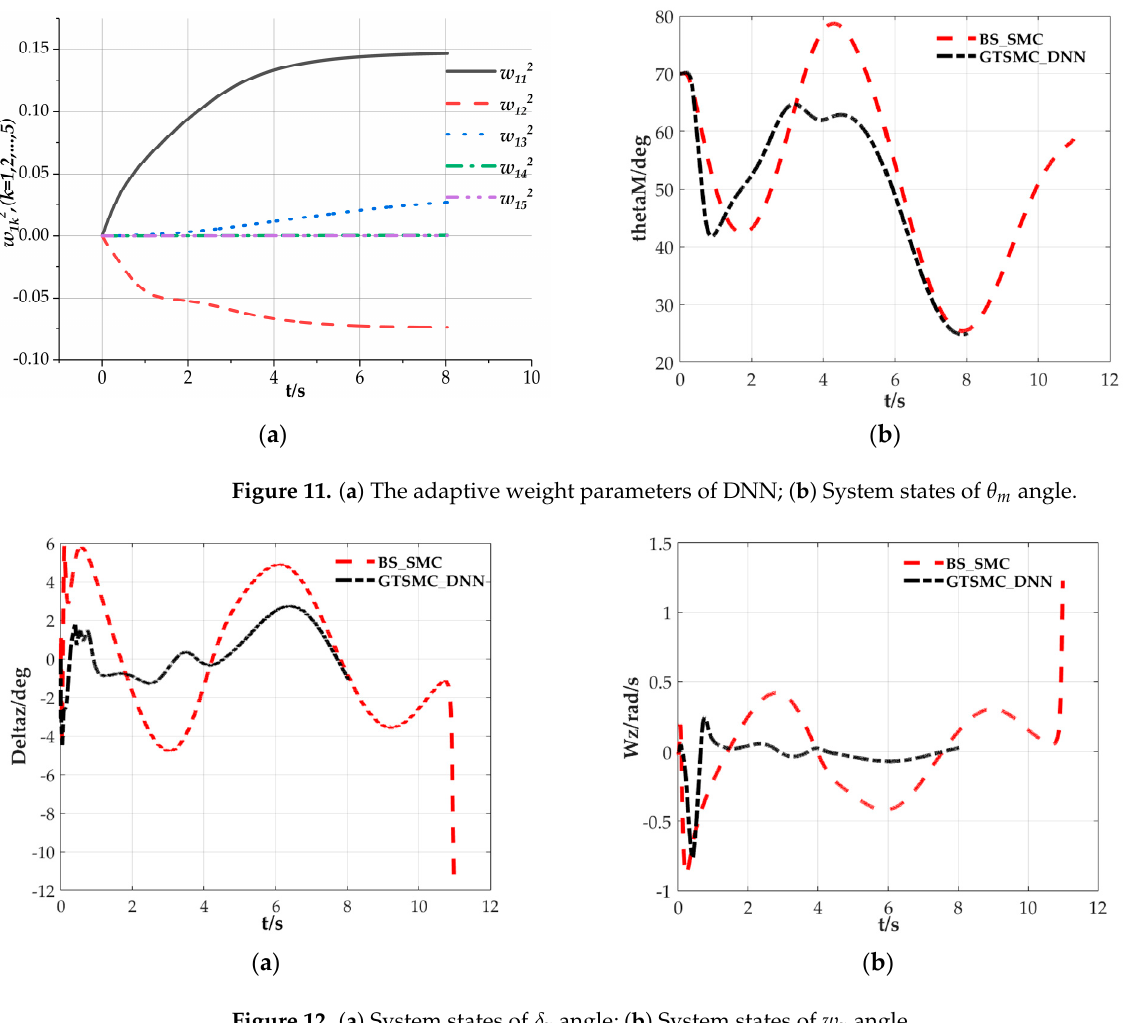
Figure 12. ( a ) System states of δ z angle; ( b ) System states of w z